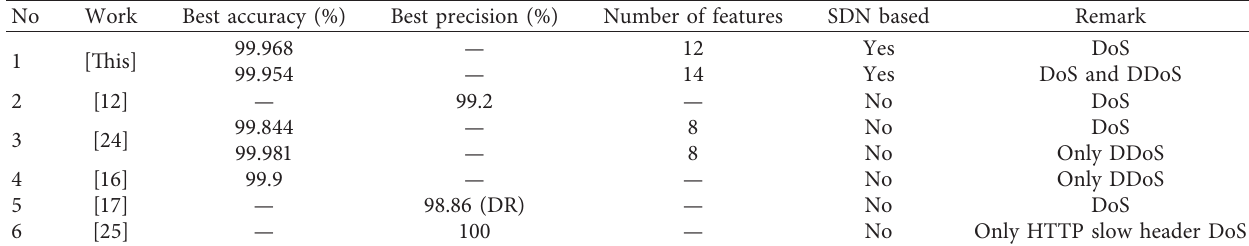
Table 7: Comparison with works targeting DoS/DDoS